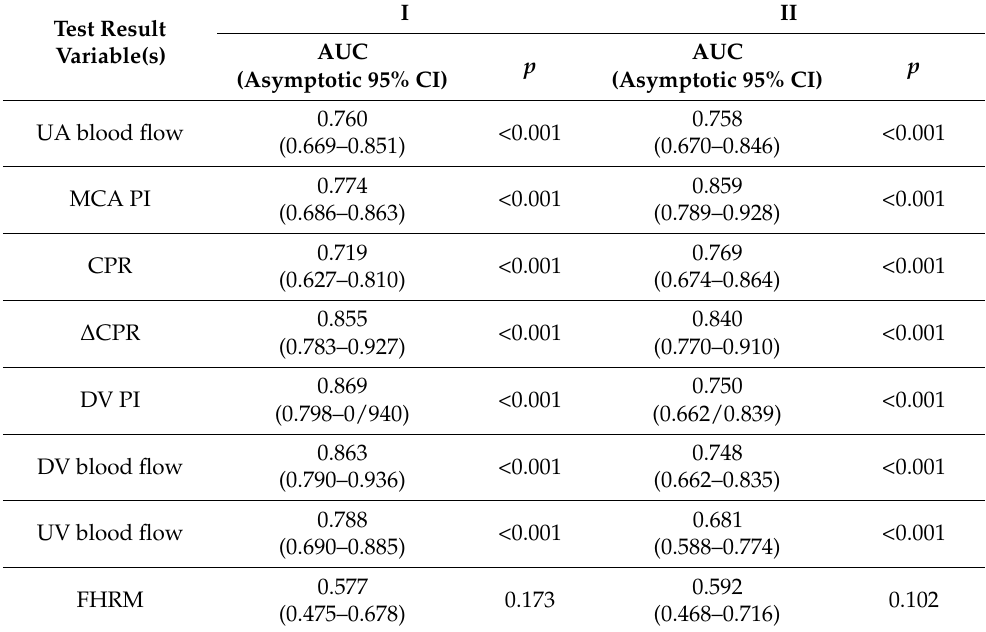
Table 4. Diagnostic parameter sensitivity and specificity—ROC by comparing: I—neonates with morbidity/mortality (bad outcome) with neonates with acidosis/asphyxia but without neonatal morbidity and neonates without neonatal morbidity/acidosis/asphyxia (good outcome) and II—ne- onates with morbidity/mortality with neonates and acidosis/asphyxia but without neonatal mor- bidity (bad outcome) with neonates without neonatal morbidity/acidosis/asphyxia (good outcome). Table 4. Cont. Test Result Variable(s)